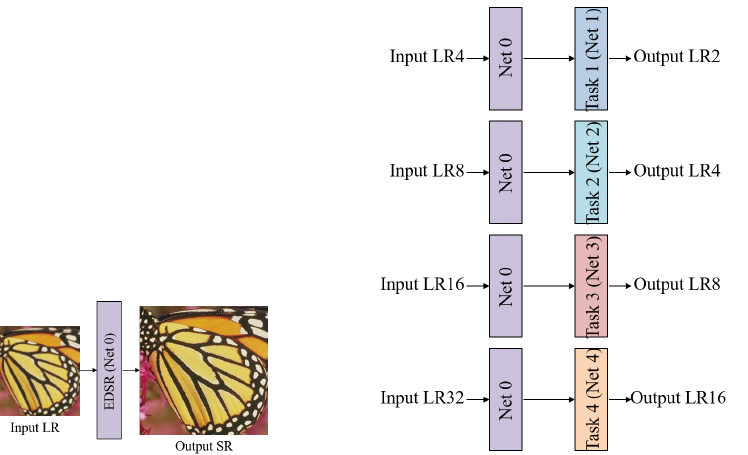
Figure 5. The left is the training process of Net0 model and the right is the training process of different